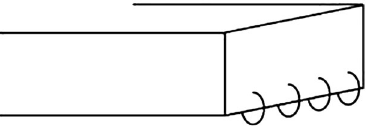
FIG. 5. Hinged door and channel for lesson